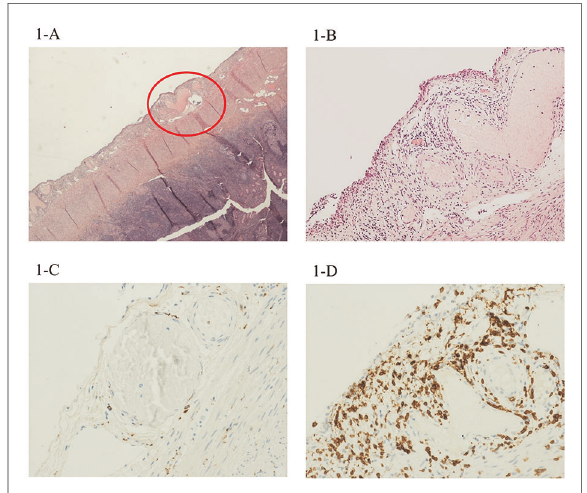
FIGURE 1 H&E image of the fi rst case, with moderate-to-severe periappendiceal in fl ammation, involving the wall of perivisceral veins. This in fi ltrate showed relatively few CD68 + macrophages ( C ) and several CD3 + lymphocytes ( D ). Magni fi cation 4× ( B ) and 20× ( A ).